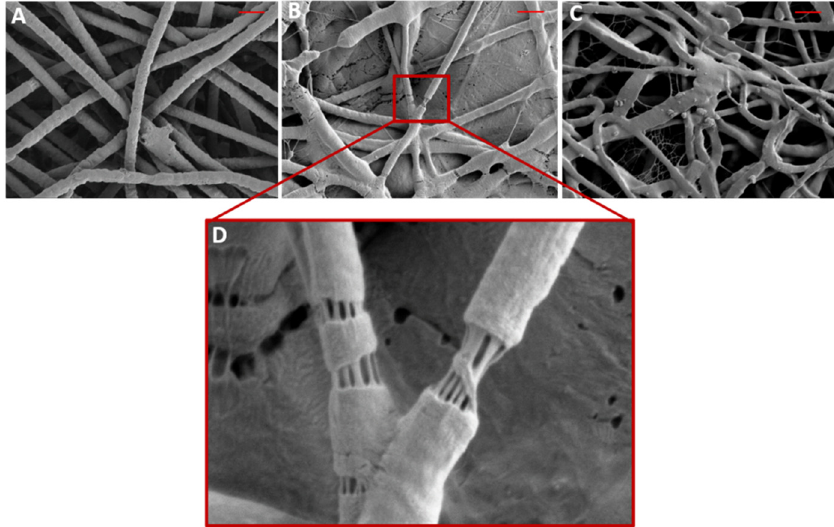
Figure 2. Representative SEM images of ( A ) electrospun PEO, ( B ) dual-spun PEO/Cerium(III) nitrate, ( C ) coaxially electrospun PEO/Cerium(III) nitrate scaffolds, ( D ) core-shell formation in coaxially electrospun PEO/Cerium(III) nitrate. Scale bar = 4 µm; Red area = 64 µm 2.